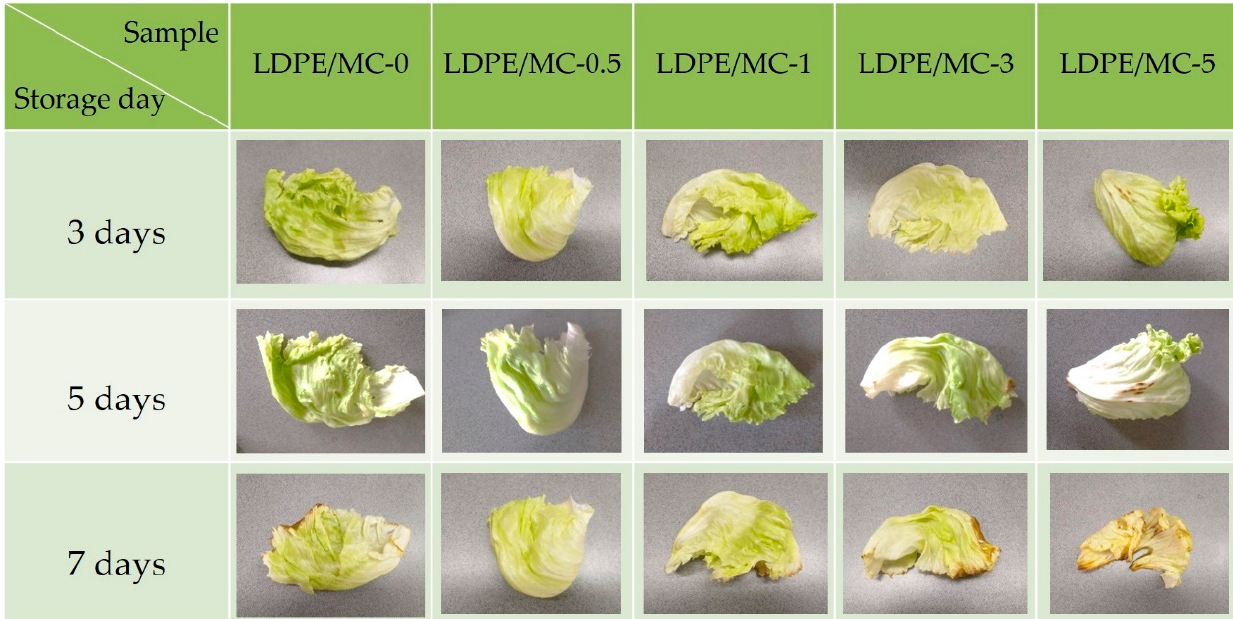
Figure 9. Photographs of lettuces packed with various LDPE/MC composite films for 3/5/7 days at 28 °C.